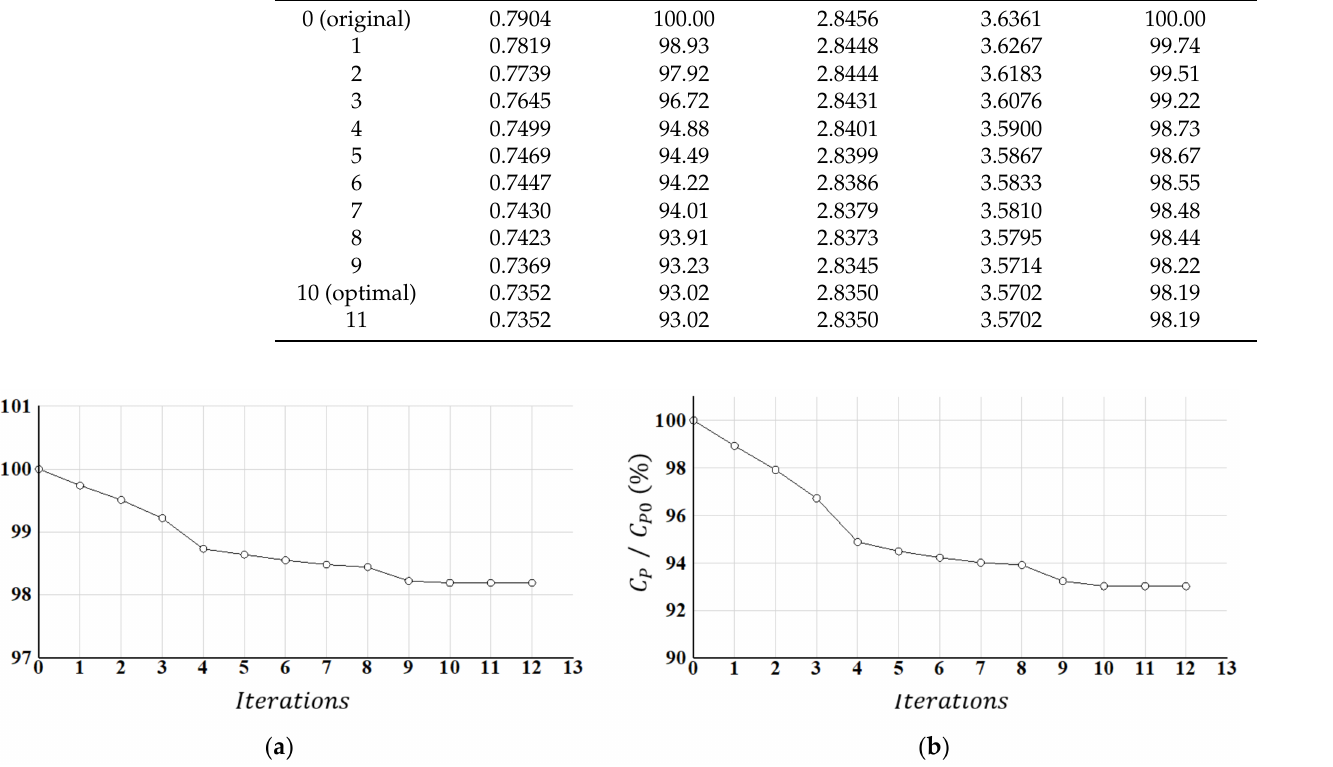
Figure 7. Convergence histories of resistance coefficients with respect to iteration number. ( a ) History of C TM / C TM 0 (%); ( b ) History of C P / C P 0